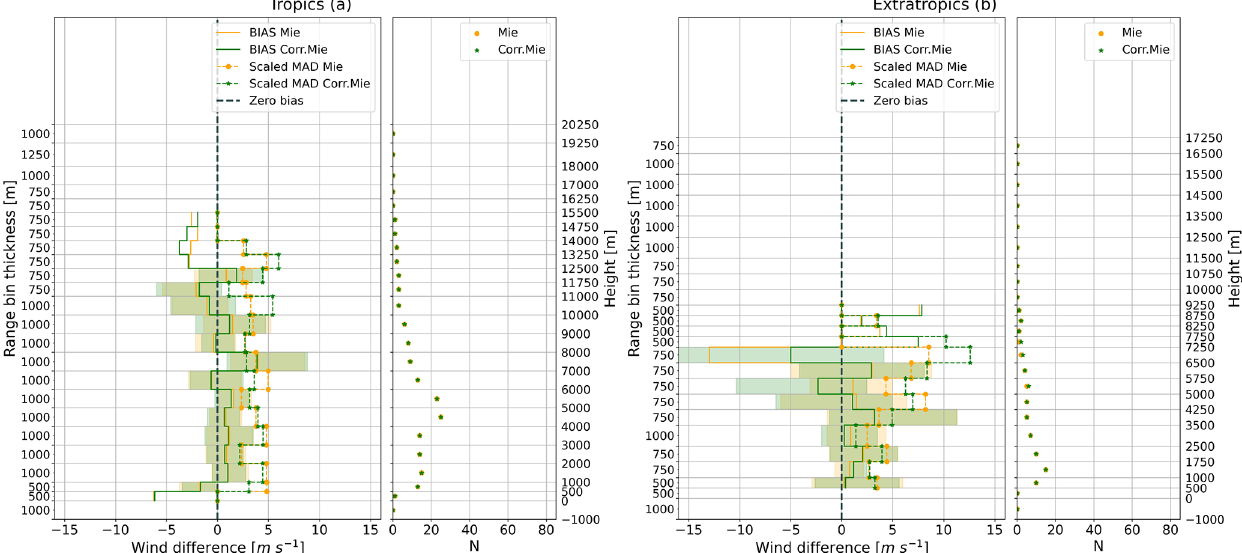
Figure A3. Wind differences (Aeolus-WPR) with range bins for the (a) tropics and (b) extratropics. Left: distributions of bias and scaled MAD of wind differences over different range bins, with shaded areas representing the uncertainty. Right: the number of available match-ups at each range bin. Orange and green colours indicate the results for Mie-cloudy and corrected Mie-cloudy winds, respectively. Note: the heights on the y axis are just for reference, which are not exactly the same as the actual heights of each vertical range bin.